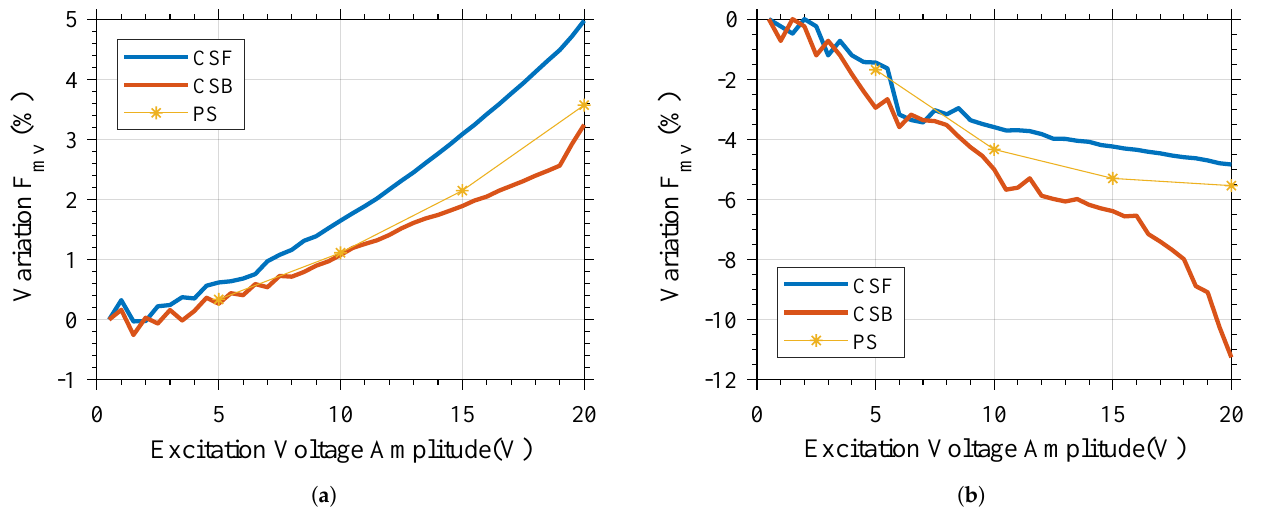
Figure 9. Influence of the amplitude and type of the excitation ( CSF , CSB , or PSF ) on F mv of ( a ) Variant 1 and ( b ) Variant